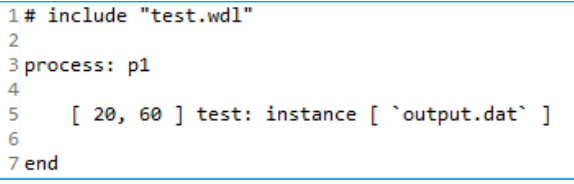
Figure 3. Process